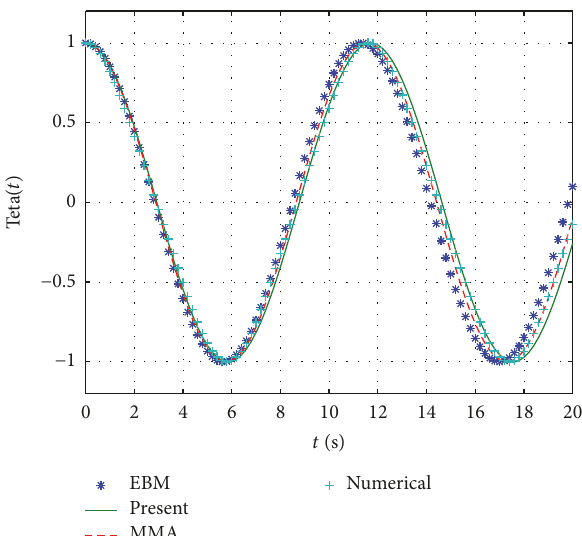
Figure 7: A comparison between the approximate and numerical solutions with Λ = 1 and 𝐴 = 1 , Example 2.